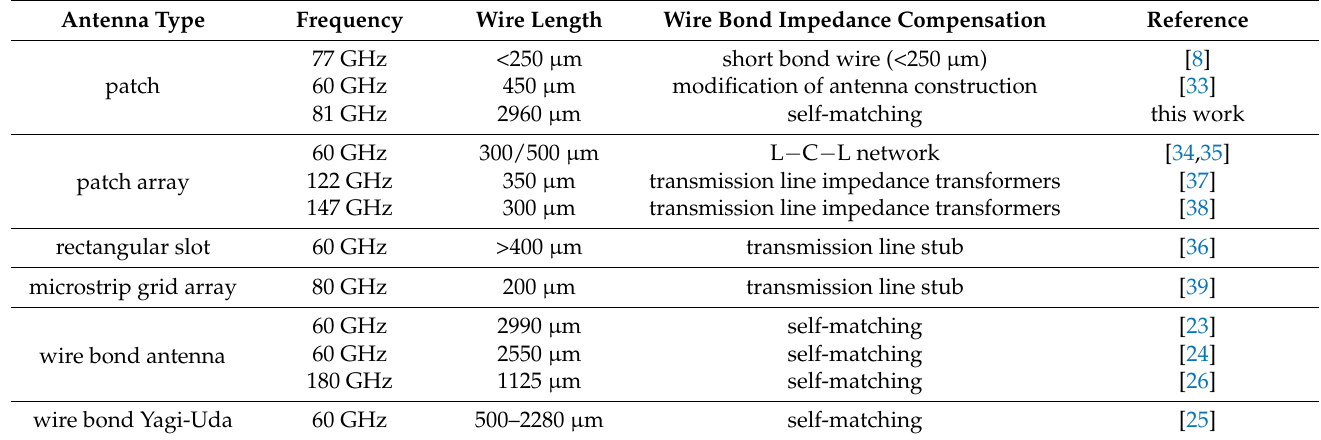
Table 1. Overview of mm-wave wire-bonded